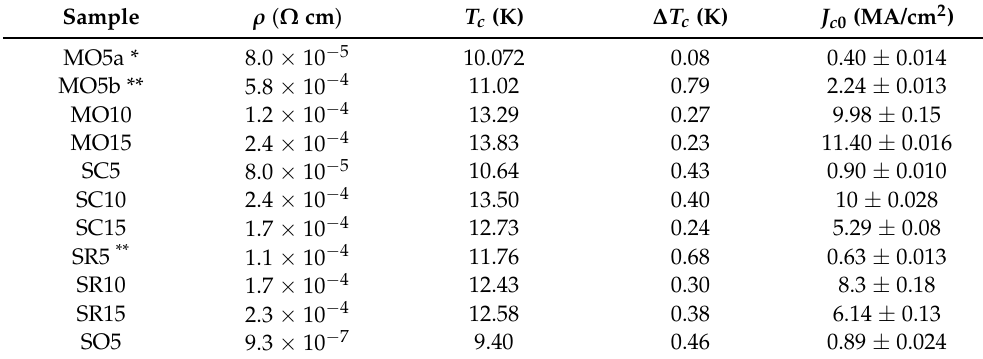
Table 1. NbN film’s properties. Starting from the left, columns are: film acronym (SC: Al 2 O 3 c-cut; SR: Al 2 O 3 r-cut; MO: MgO; SO: SiO 2 ; the number following the two letters refers to the film thickness in nm units); resistivity value at 15 K; superconducting transition temperature; superconducting transition width; superconducting critical-current density at 0